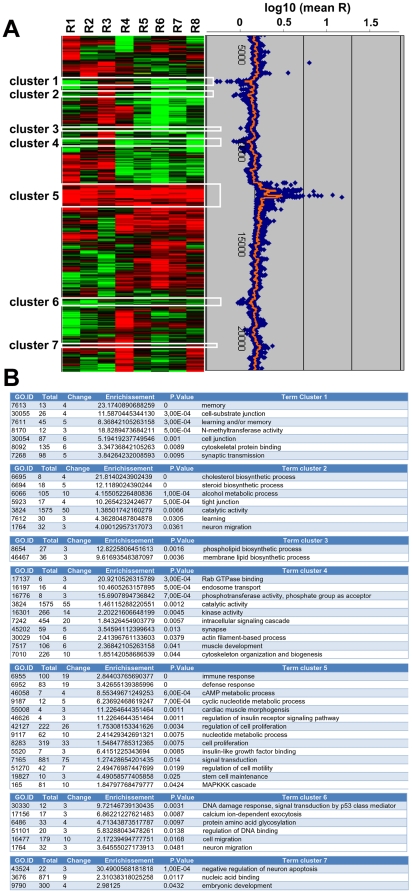
Gene expression analysis following Arx expression in N2a cells.A) Heat map representing hierarchical clustering of the ratio “Arx-transfected cells/control-transfected cells” in 8 different replicates. Each row represents a gene and each column, a sample. Levels are color-coded with red, green and black, corresponding to an increase, decrease or no change in gene expression, respectively. Seven clusters of genes with the same regulation were identified. B) Functional annotation of genes in the seven clusters using the GoMiner program.